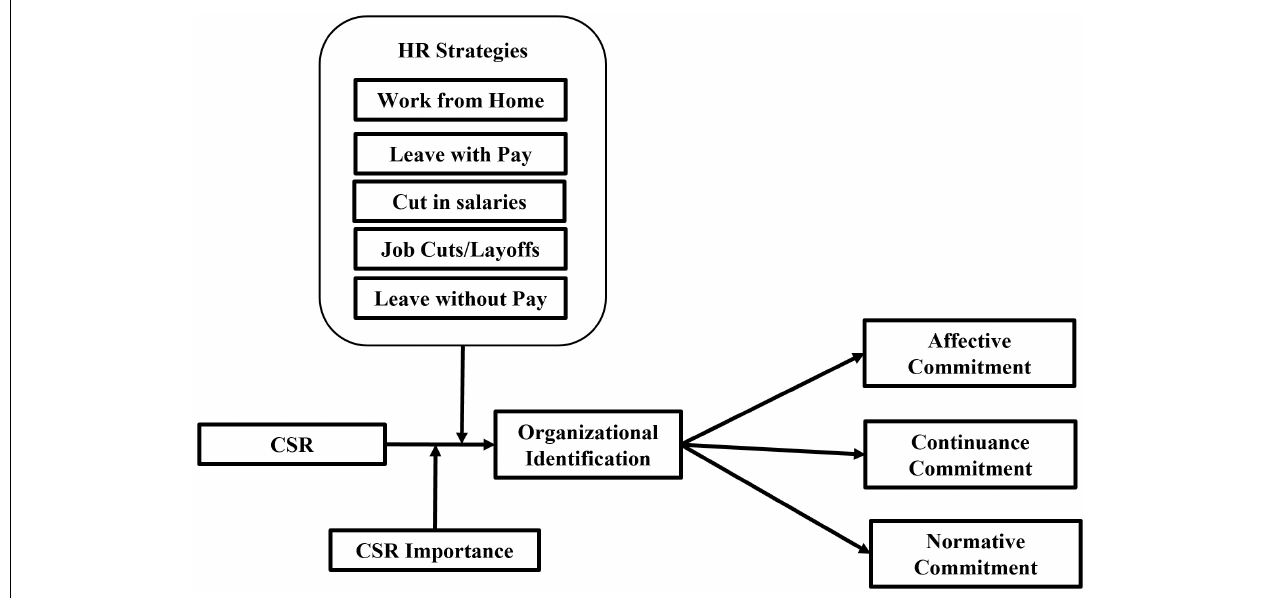
FIGURE 1 | The study